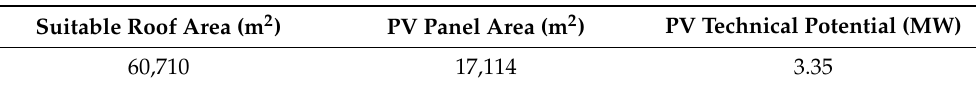
Table 5. Linosa PV technical potential on roofs.